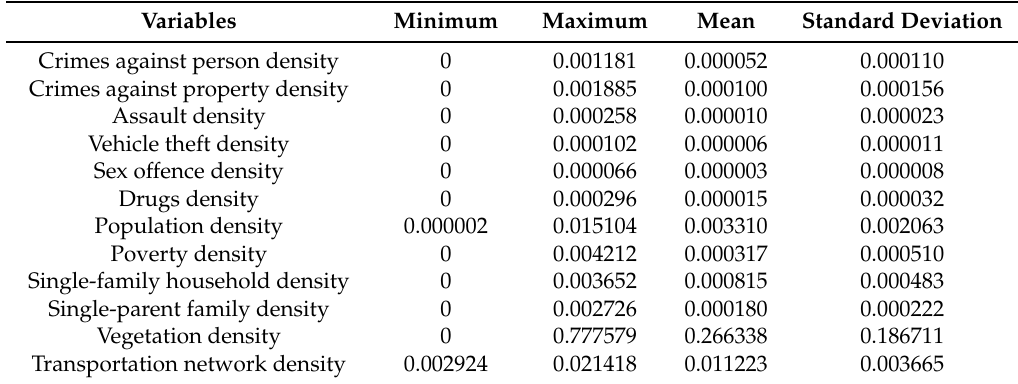
Table 2. Descriptive statistics of dependent and independent